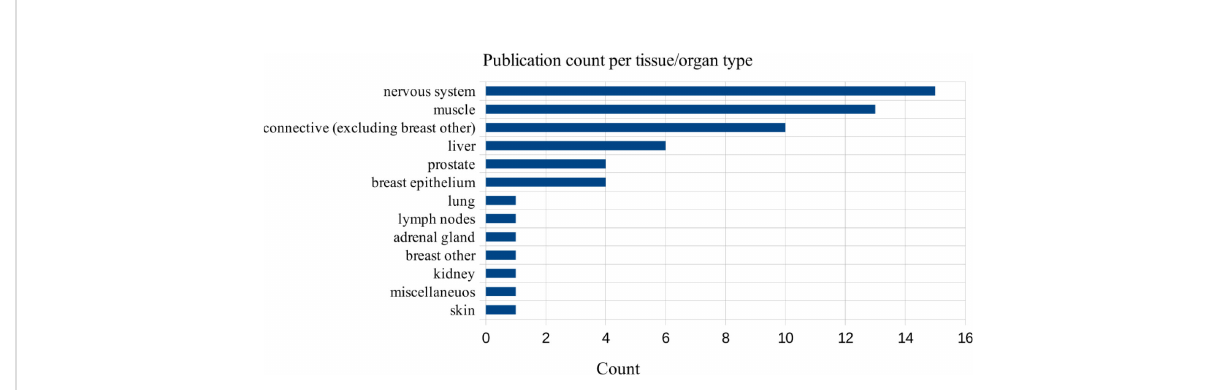
FIGURE 3 The number of studies in a detailed review, grouped by organs and tissues, total =